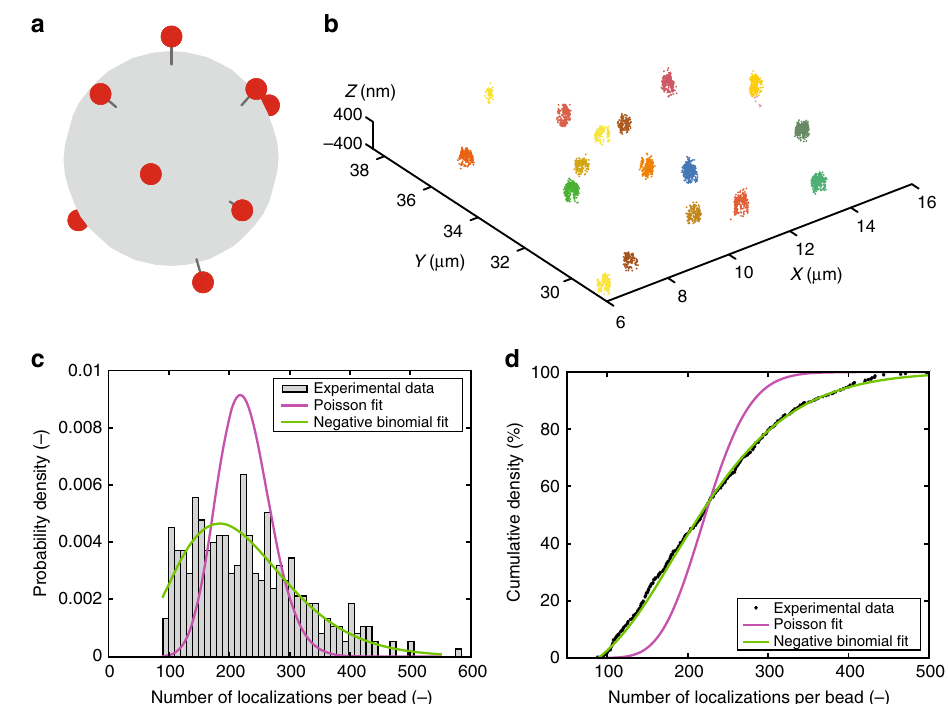
Fig. 3 dSTORM imaging of dye-functionalized nanoparticles. a Schematic depiction of a spherical nanoparticle, functionalized with multiple Alexa647 fl uorophores. The average density of the fl uorophores can be adjusted by varying reaction conditions. b dSTORM image of multifunctional nanoparticles. Medium-density nanoparticles were immobilized on a glass coverslip and imaged using astigmatic 3D-dSTORM. c Probability mass function of the number ¼ 379. The probability mass function has been fi t using a conditional compound Poisson distribution of localizations per nanoparticle (grey bars), N (cid:1) (cid:3) beads ; representing the functionalization reaction as a completely random arrival process. An alternative fi t has been (solid magenta line), Poisson ^ λ ¼ 46 : 82 performed using a conditional compound negative binomial distribution (solid green line), NBinomial ð ^ r ¼ 6 : 54 ; ^ p ¼ 0 : 12 Þ , indicating a functionalization process with increased dispersion. d Cumulative probability distribution of the number of localizations per bead (solid points). The plot shows an improved quality of the fi t for a compound negative binomial function (solid green line) compared to a compound Poisson function (solid magenta line). Details of the distributions used in c and d can be found in the Supplementary